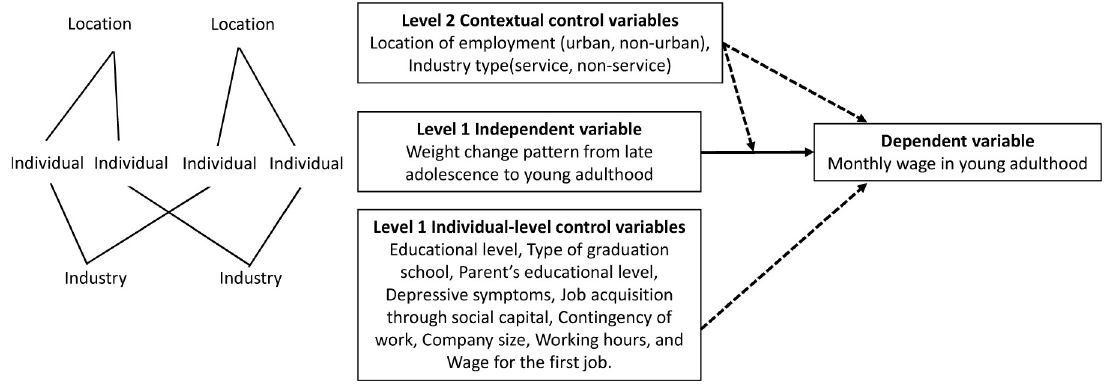
Fig 2. Cross-classified hierarchical structure of